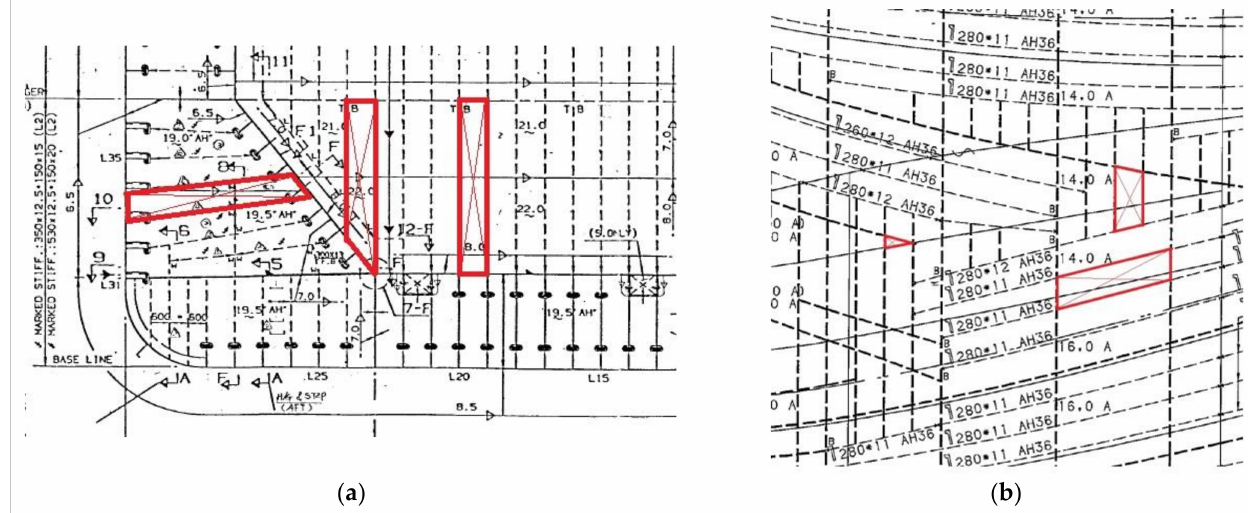
Figure 1. Variants of the loop shape of real EPPs on the transverse bulkhead ( a ) and ship outer shell plating ( b